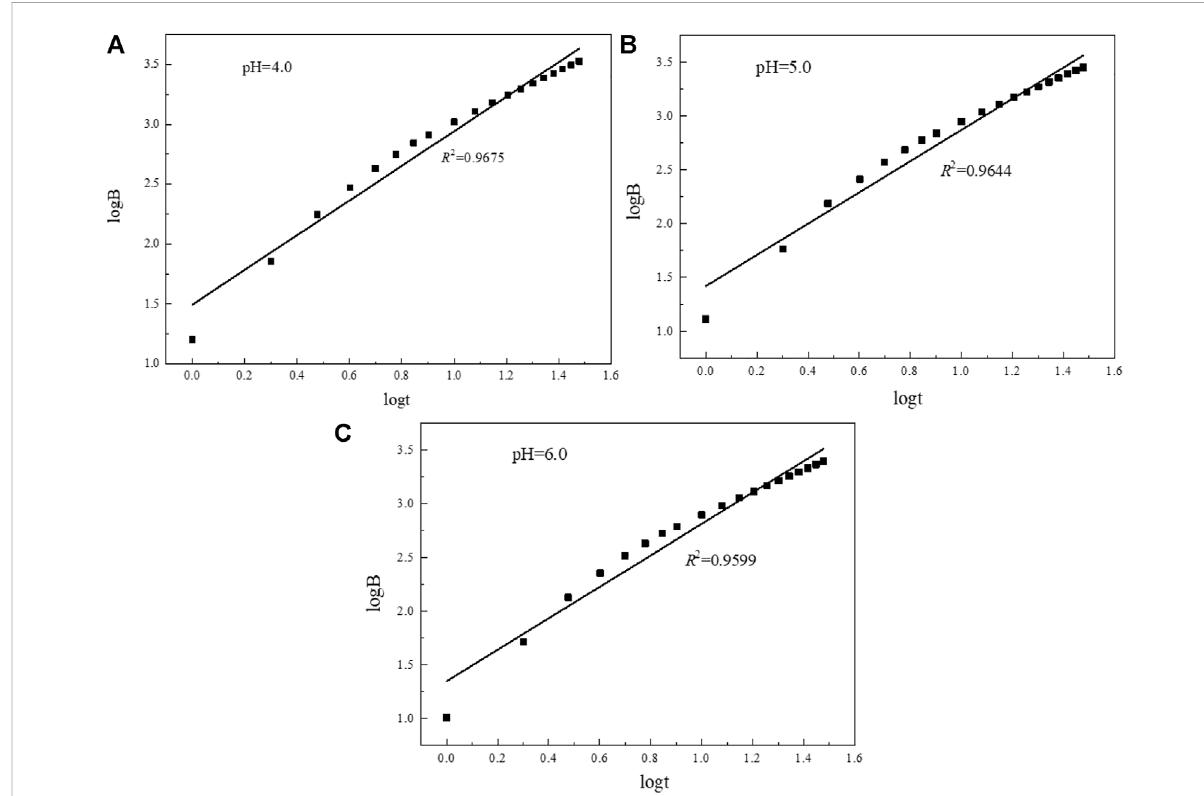
FIGURE 16 Linear fi tting curves of uranium in tailings under different pH rainfall conditions. (A) pH=4.0; (B) pH=5.0; (C) pH=6.0.